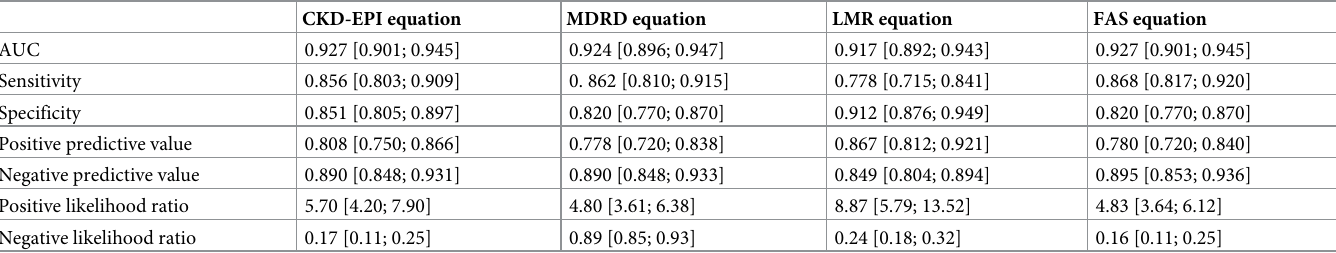
Table 4. Receiver-Operating Curve (ROC) analysis of equations estimating GFR to predict a mGFR < 45mL/min/1.73m 2 (n =